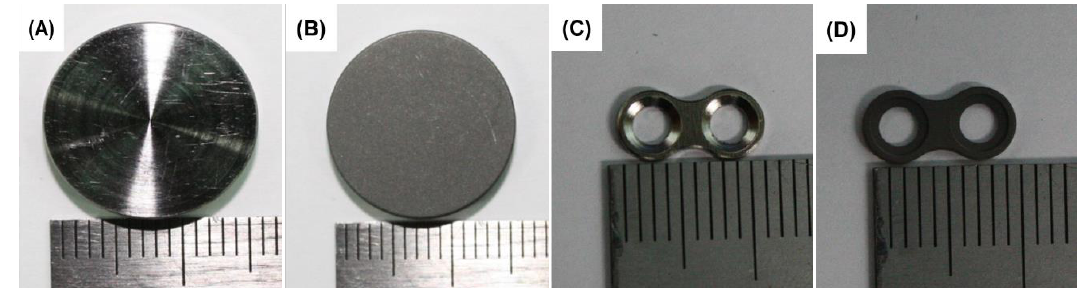
Figure 1. A Ti disk with no treatment ( A ) and sandblasted with large acid-etched grits (SLA) treated Ti disk ( B ). Ti disks were used as sample for surface analysis and in vitro evaluation. Untreated